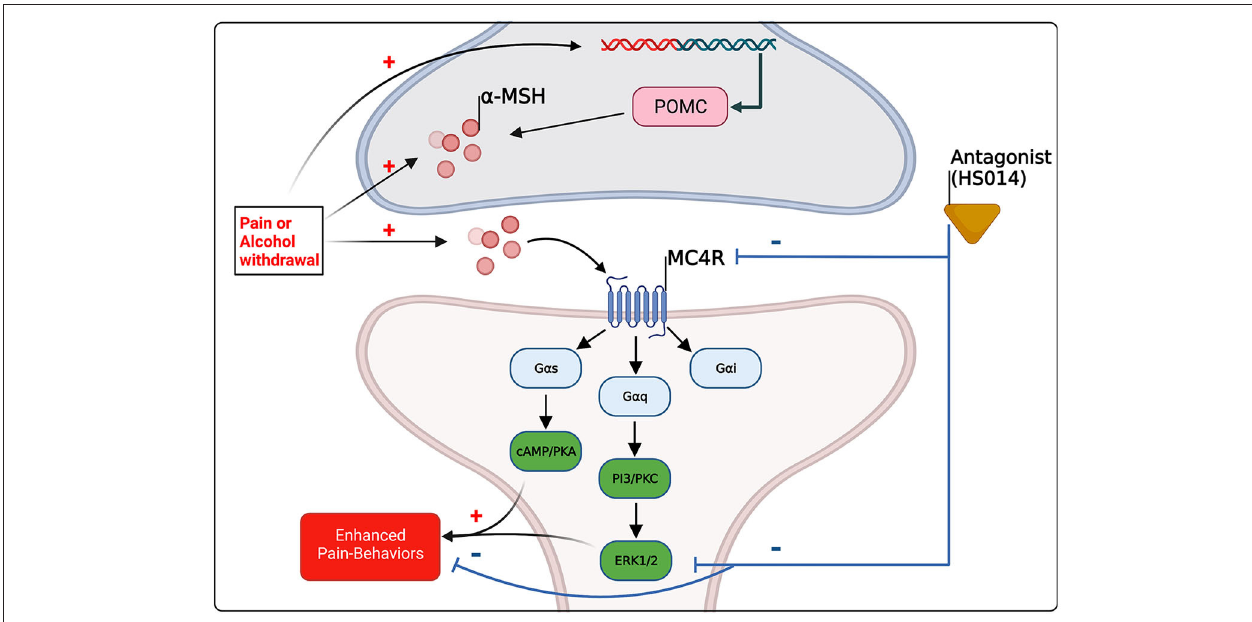
FIGURE 2 | Schematic summary of the evidence-based and hypothetical effects of pain and alcohol withdrawal on melanocortin signaling within the central nervous system, and of the effects of altered melanocortin signaling on pain-related behaviors. Pre-clinical evidence suggests that pain and alcohol withdrawal [see (98, 105)] are associated with increased melanocortin tone through increases in α -MSH and/or POMC in brain regions implicated in pain and substance abuse, including the amygdala. MC4R couples to all three major G-coupled protein pathways, however activation of PKA and the mitogen activated protein kinase (MAPK) ERK1/2 are associated preclinically with pain-states (145, 146), and antagonism of MC4R reduces pain-related outcomes and results in decreases in ERK1/2 activation (72). The molecular mechanisms underlying MC4R drug effects on alcohol intake remain unclear.